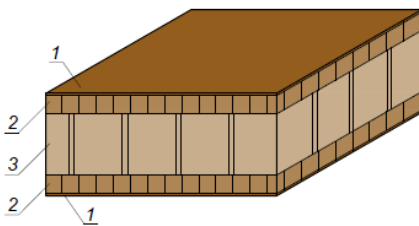
Figure 3. Cardboard honeycomb panel with a thickness of 50 mm, manufactured by Egger, Austria, δ = 50 mm: 1. Decorative foil; 2. PB, δ = 8 mm; 3. honeycomb cardboard core.